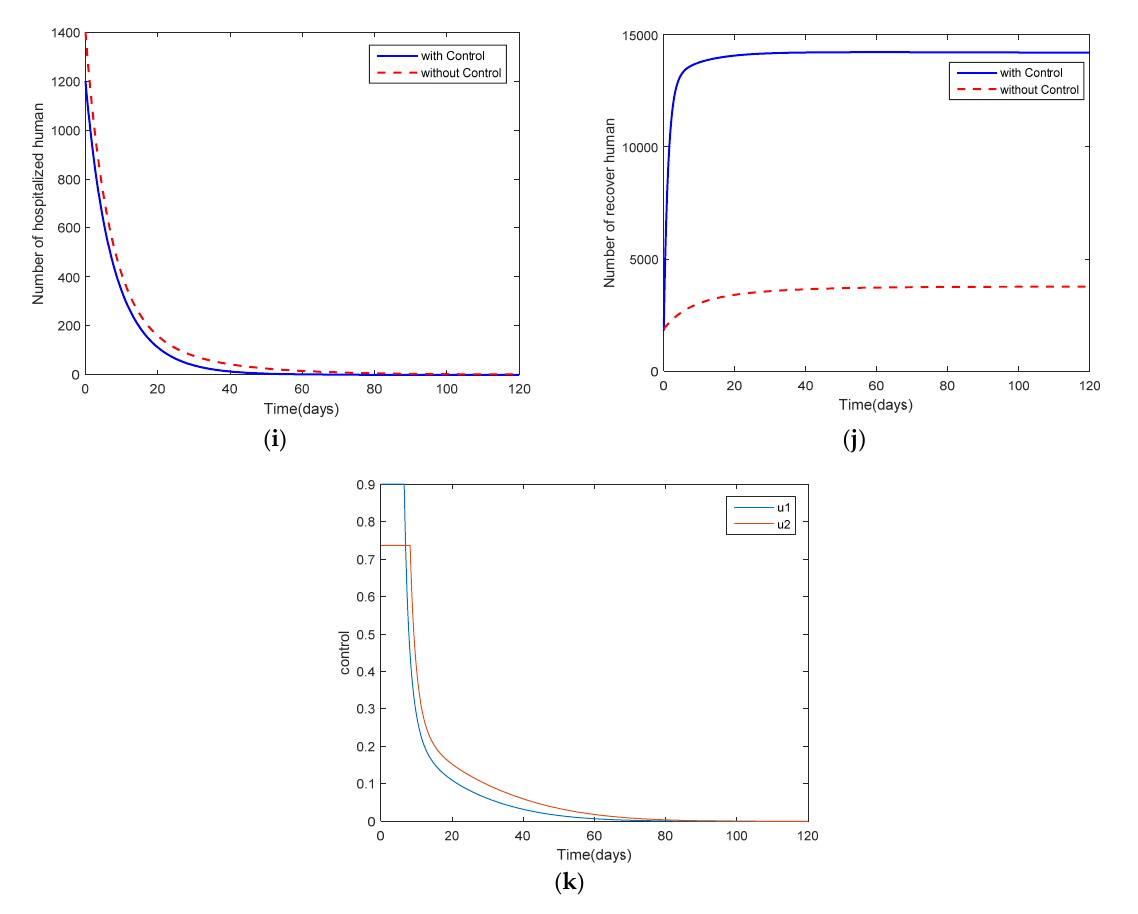
Figure 10. Comparison between the cases with control and the cases without control for the disease-free: ( a ) the number in the unvaccinated, susceptible population; ( b ) the number in the unvaccinated, exposed population; ( c ) the number in the unvaccinated, asymptomatic, infected population; ( d ) the number in the unvaccinated, symptomatic, infected population; ( e ) the number in the vaccinated, susceptible population; ( f ) the number in the vaccinated, exposed population; ( g ) the number in the vaccinated, asymptomatic, infected population; ( h ) the number in the vaccinated, symptomatic, infected population; ( i ) the number in the hospitalized population; ( j ) the number in the recovered population; and ( k ) control efforts u 1 ( t ) and u 2 ( t ) . with Control without Control